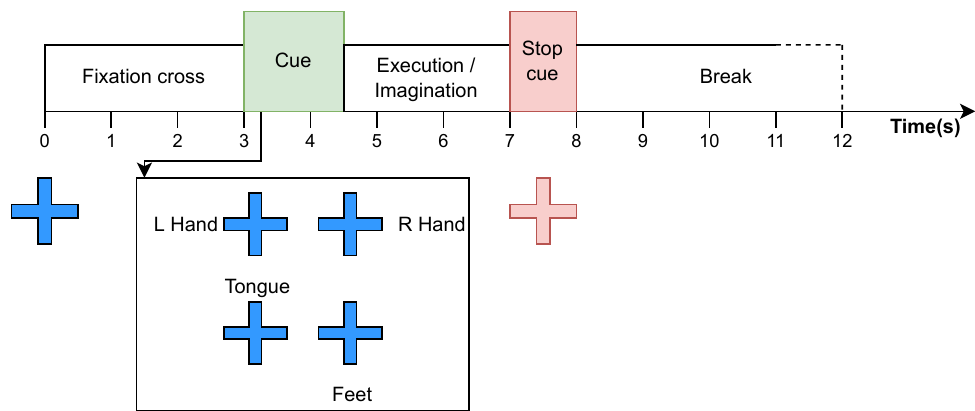
Figure 1. One trial in a calibration run of the data acquisition procedure. For feedback runs, a BCI decoding model was trained on previously acquired MI calibration data to give feedback after each movement imagination. The calibration data were always acquired at the beginning of the session and no data from previous sessions were used. The feedback consisted of a textual message that informed the participant if the decoded movement matched the requested movement. If there was a mismatch, the predicted movement was also shown. Feedback runs always used imagined movements. At the end of each feedback run, participants were informed of the proportion of correctly predicted movements to provide them with a target to improve upon. Figure 2 shows the procedure of a single trial during a feedback run. Feedback runs consisted of 8 repetitions per movement, resulting in 32 trials per run.